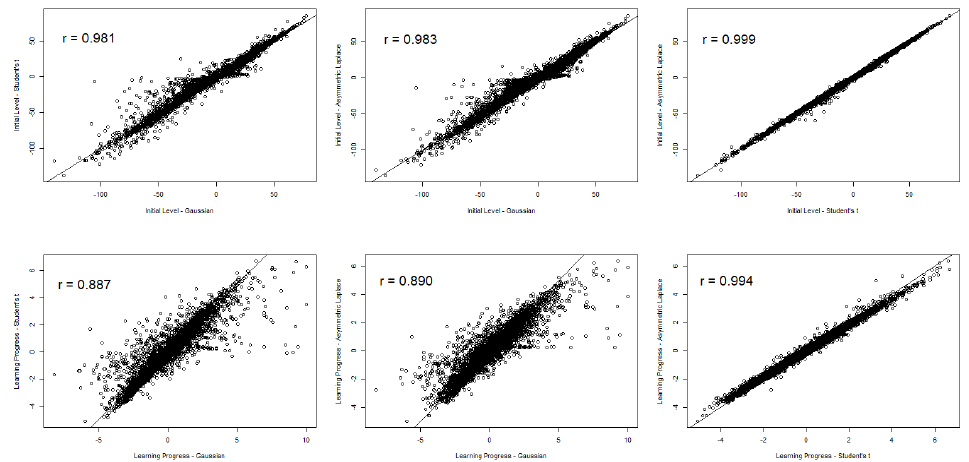
Figure 3. Bivariate scatter plots between initial level and learning progress estimates.